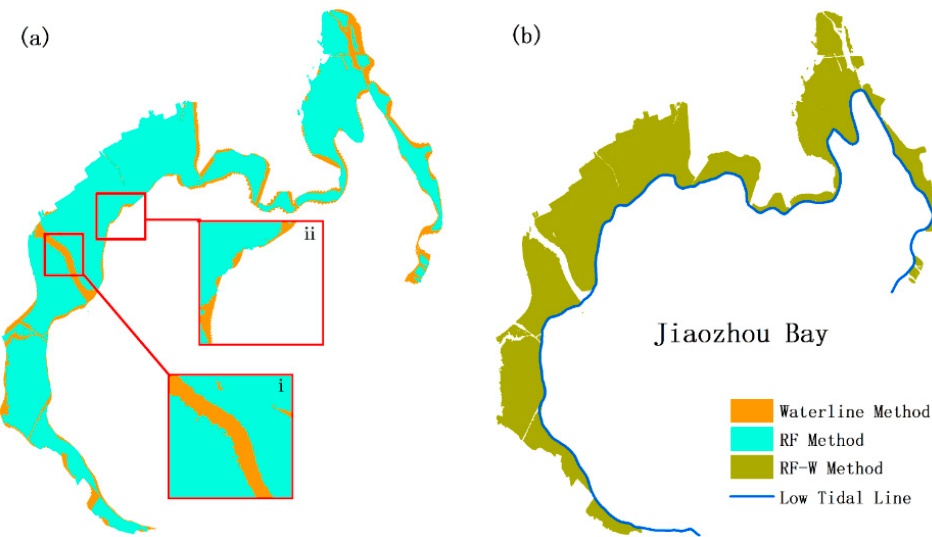
Figure 9. Combination of the RF method and waterline method to extract tidal flats. ( a ) Comparison of the extraction results of the two methods; ( b ) RF-W model extraction result.